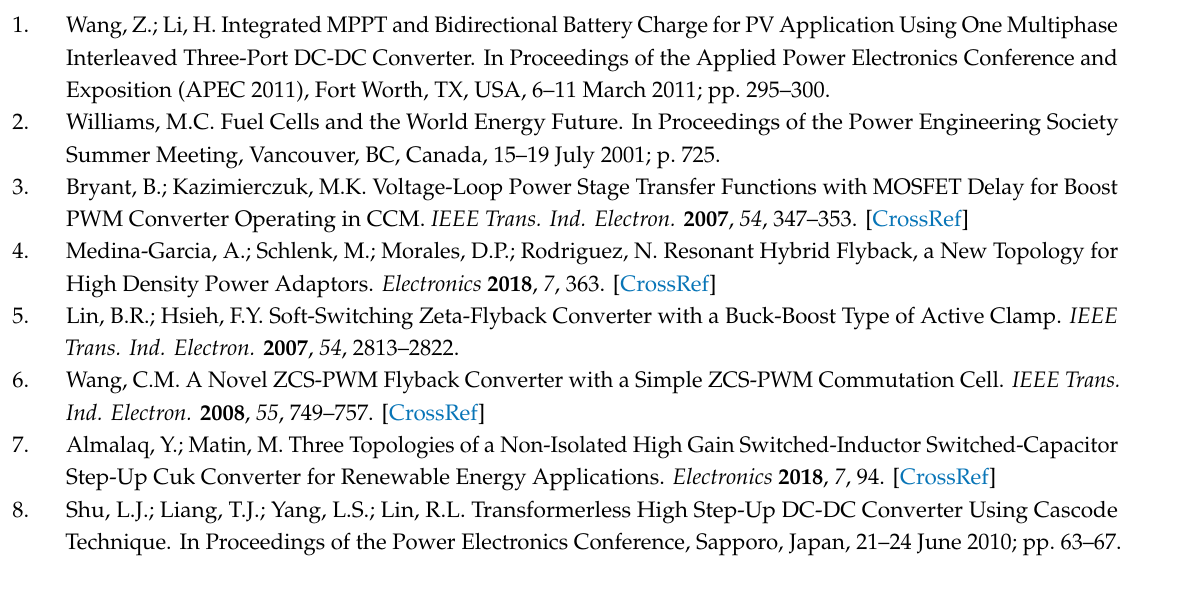
Figure 21. Photo of the prototype.